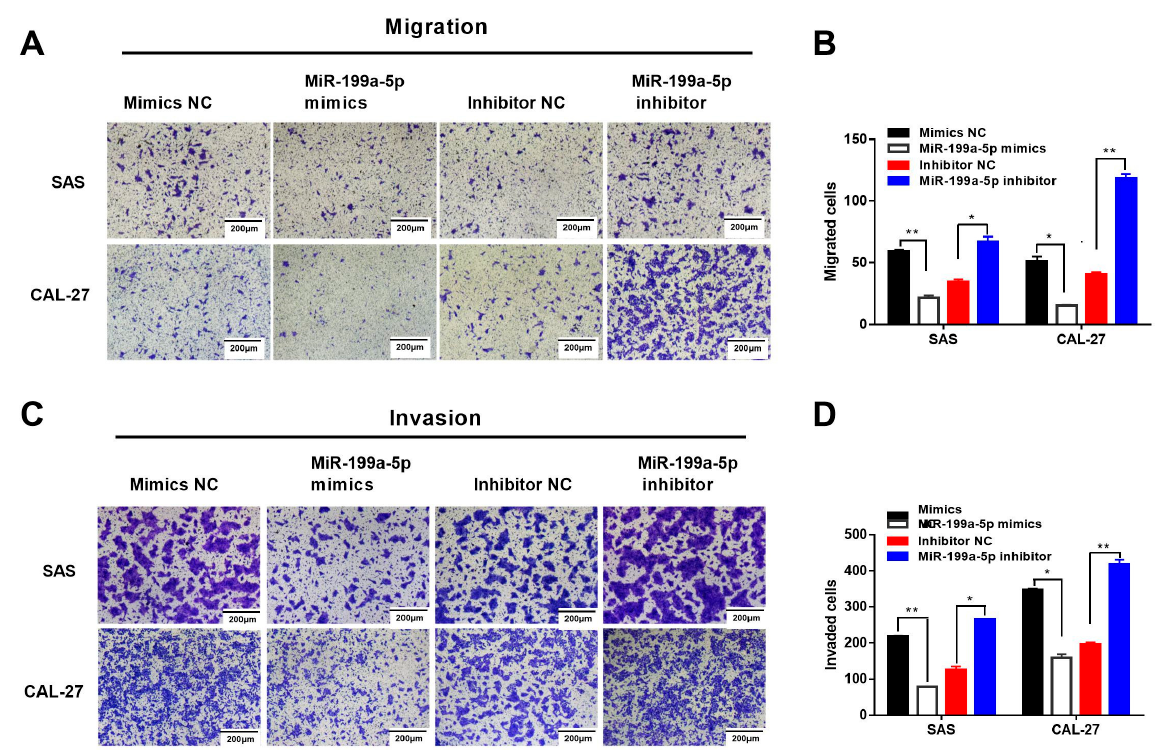
Figure 6. MiR-199a-5p inhibits OSCC cell migration and invasion. The effect of miR-199a-5p mimics or miR-199a-5p inhibitors on OSCC cell migration and invasion. SAS or CAL-27 cells were transfected with miR-199a-5p mimics or miR-199a-5p inhibitors for the indicated times (24 h for SAS, 48 h for CAL-27). Cell migration ( A ) and invasion ( C ) were assessed by Transwell migration and invasion assays. Scale bar: 200 µ m. Quantitative analysis was performed using the Image J software ( B , D ). Data are expressed as the mean ± SEM from triplicate experiments. * p < 0.05, ** p <